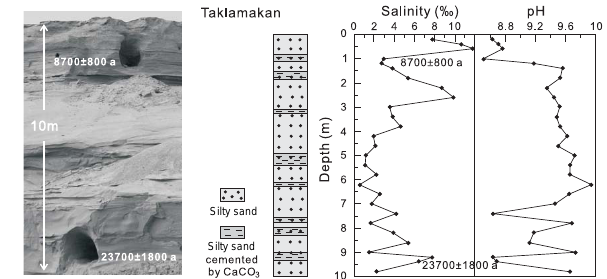
Figure 7. Sequential variations in soluble salt contents (salinity and pH) of the Tazhong-XIII section in the Taklamakan Desert.